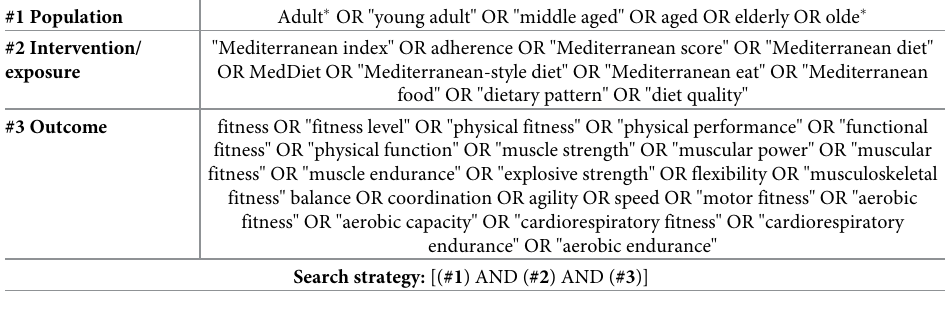
Table 1. Search strategy for the MEDLINE